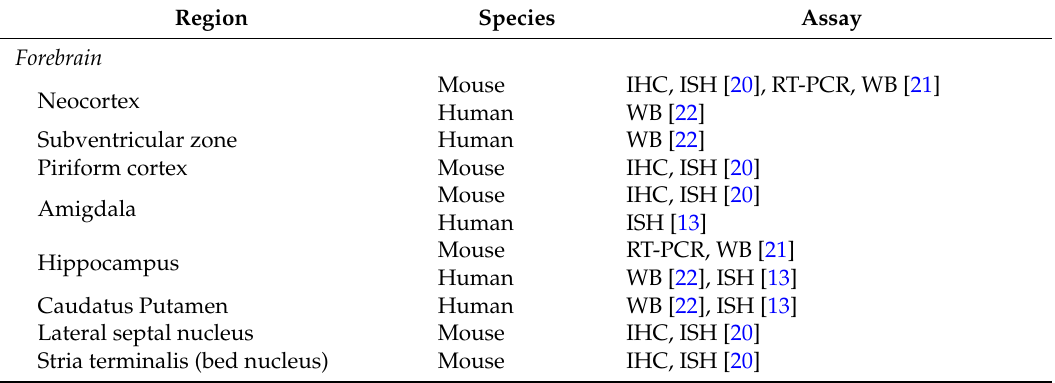
Table 1. CNS areas expressing NGB.